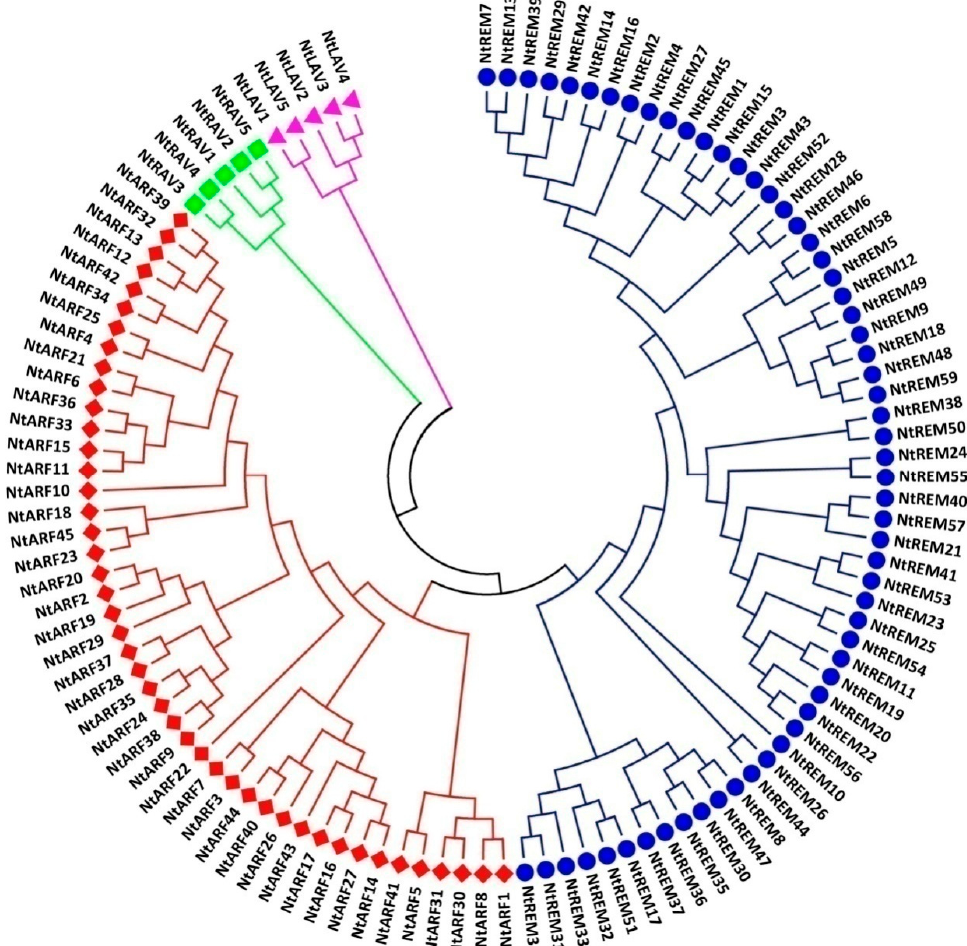
Figure 1. Phylogenetic analysis of B3 proteins in tobacco. The phylogenetic tree was constructed using the ML (Maximum likelihood) method with 1000 bootstrap replications based on the JTT matrix-based model.